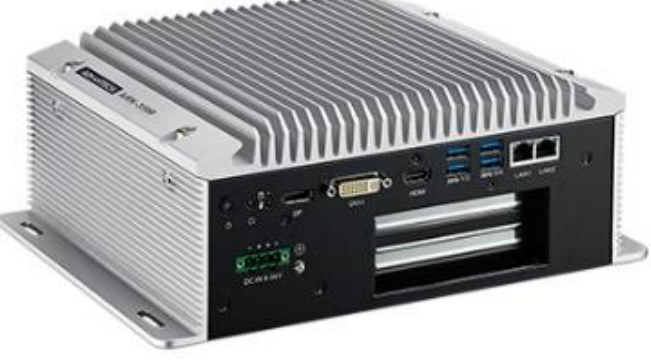
Figure 23. Industr i al personal computer (ARK-3500). Figure 23. Industrial personal computer